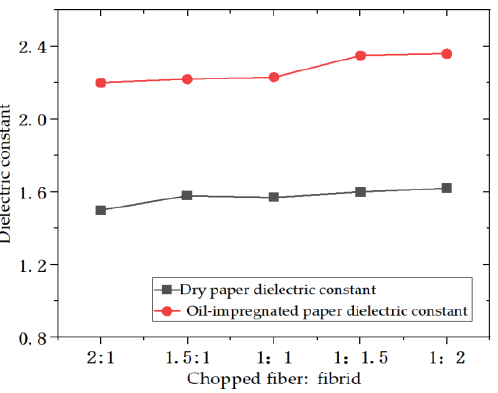
Figure 6. Dielectric constant of insulating paper with different fiber ratios.